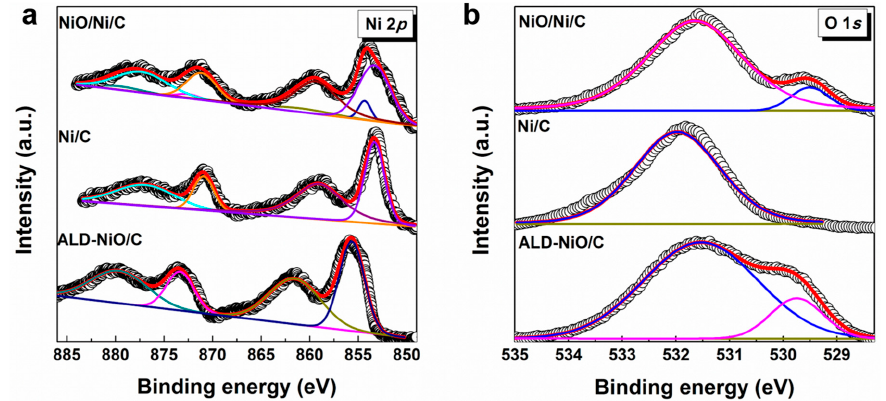
Figure 3. X-ray photoelectron spectrum (XPS) of ALD-NiO/C, Ni/C and NiO/Ni/C samples. ( a ) Ni 2 p ; ( b ) O 1 s .